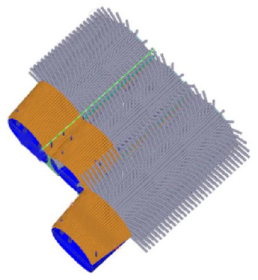
Figure 10. Construction of the pipe roofings.